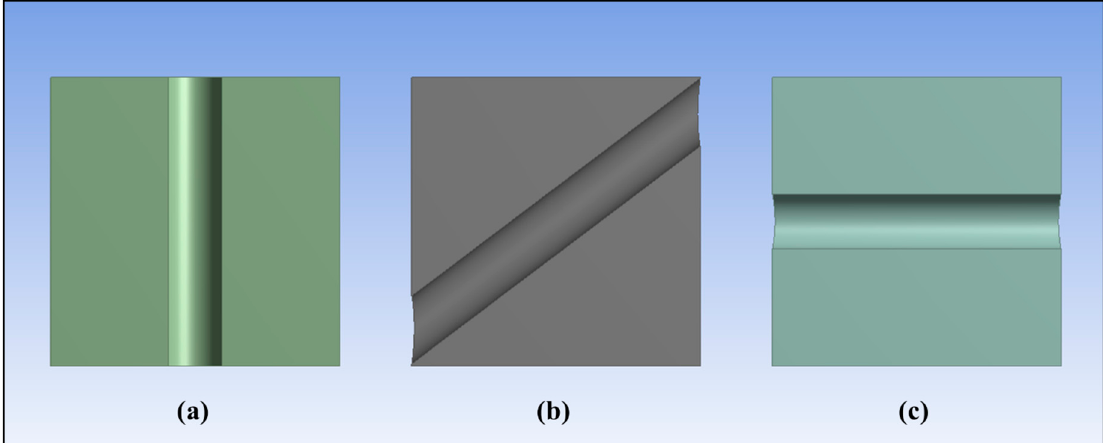
Figure 1. Drill hole positions and orientations for ( a ) Vertical ( b ) Angular and ( c ) Horizontal drills.